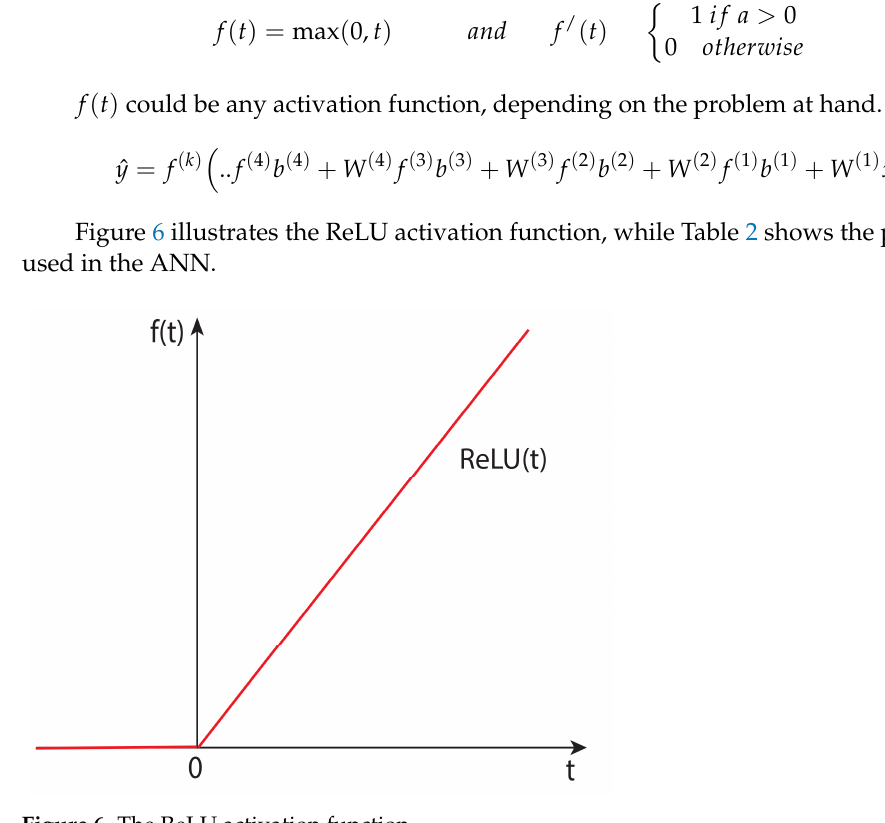
Figure 6. The ReLU activation function. Table 2. ANN